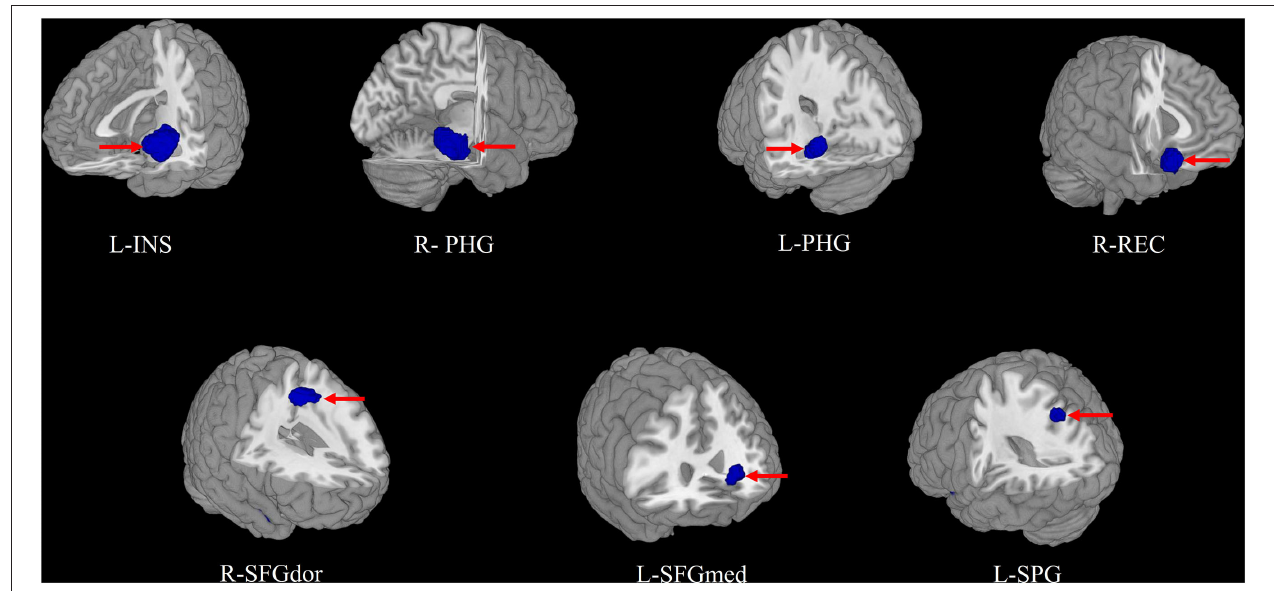
FIGURE 2 | The areas of decreased (blue) gray matter volumes in patients with first episode depression (FED) compared with healthy controls in the pooled meta-analysis. INS, insula; PHG, parahippocampal gyrus; REC, gyrus rectus; SFGdor, superior frontal gyrus, dorsolateral; SFGmed, superior frontal gyrus, medial; SPG, superior parietal gyrus; L, left; R,